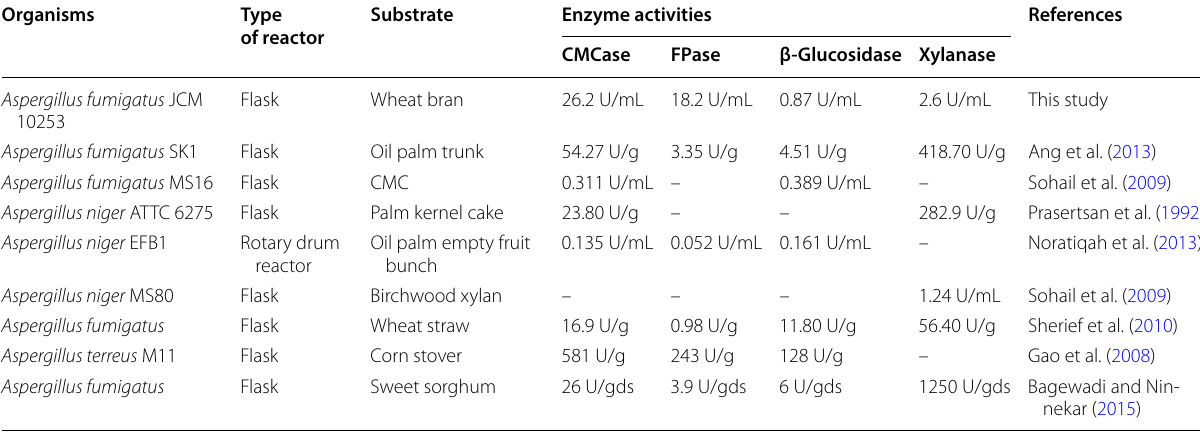
Table 5 Comparison of cellulases and xylanase produced by Aspergillus sp. with different substrates